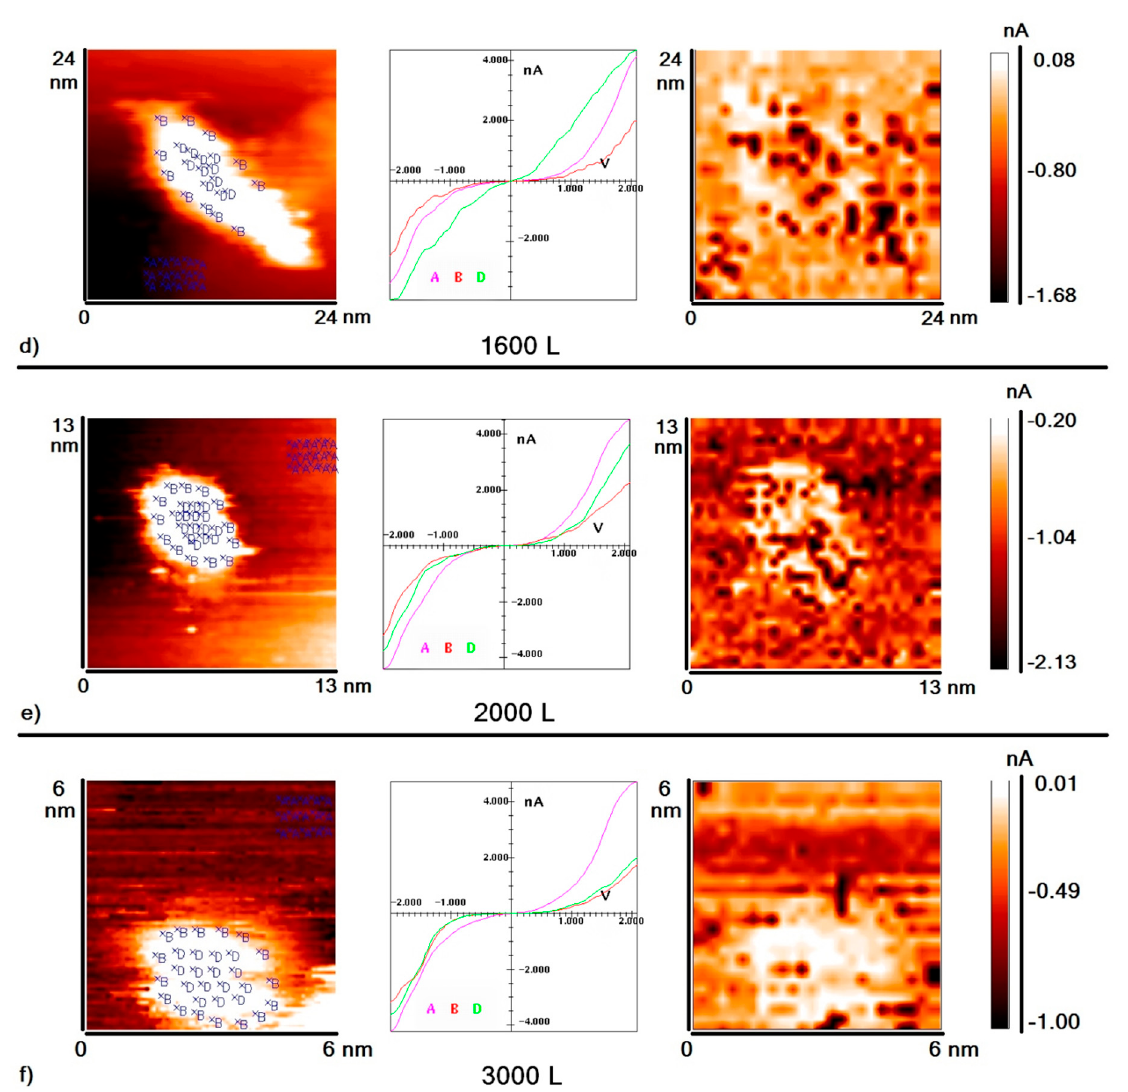
Figure 2. Topography image, VAC, and current image of gold nanoparticles and HOPG at di ff erent Figure 2 (cont.). Topography image, VAC and current image of gold nanoparticles and HOPG at the experimental stages. The letter designation of the curves corresponds to the points on the topography. different stages of experiment. The letter designation of the curves corresponds to the points on the After exposure to deuterium: ( a ) 200 L; ( b ) 800 L; ( c ) 1200 L; ( d ) 1600 L; ( e ) 2000 L; ( f ) 3000 topography. After exposure to deuterium: ( d ) 1600 L; ( e ) 2000 L; ( f ) 3000 L.